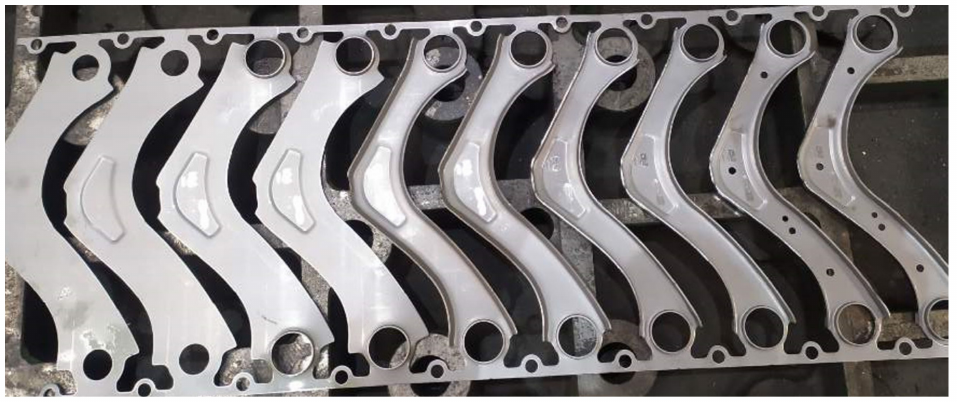
Figure 4. Stamping